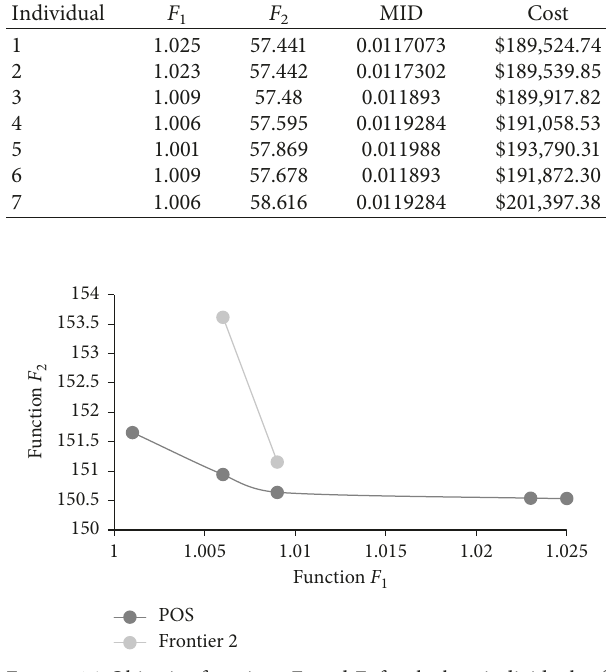
1 and F 2 for the best individuals of